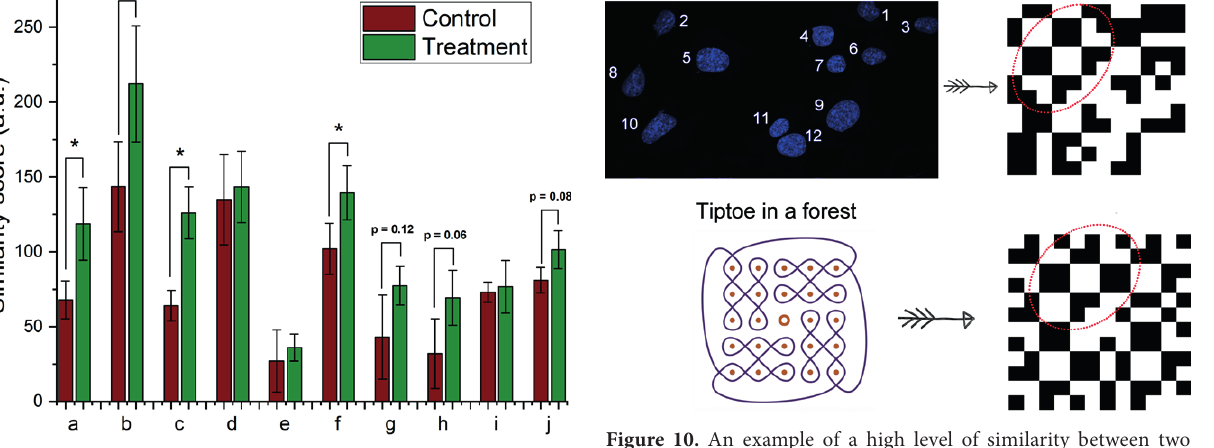
Figure 10. An example of a high level of similarity between two digital checkerboard patterns, one obtained from an image of the treated cells and another from a sona drawing representing tiptoeing in a forest. Adjacent squares and ⅃ shapes are denoted as discernable in both the cell pattern and the comparative lusona pattern.